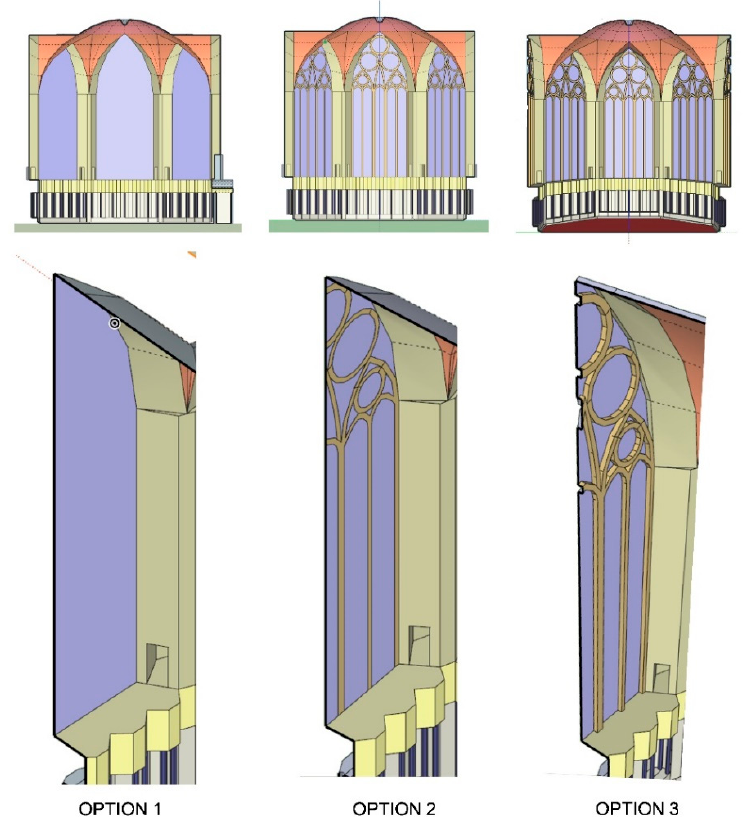
Figure 5. Acoustic model of the York Minster’s Chapter House. Detail of the simplifications including the limestone canopies and the three options tested for the limestone clusters of shafts or nerves framing the stained glasses.